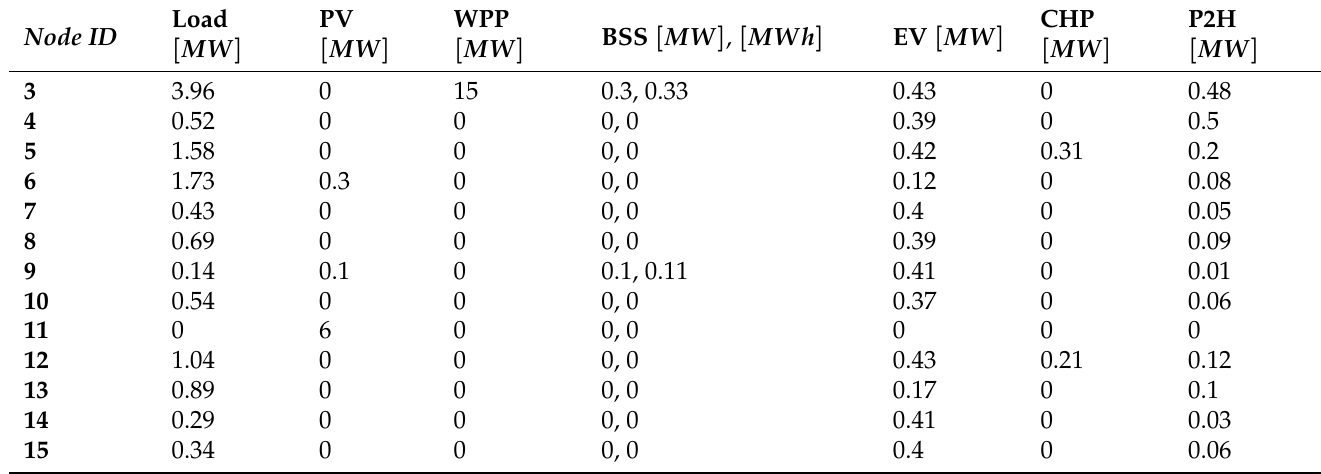
Table A1. Installed Capacities of the distributed technologies within the 15-node